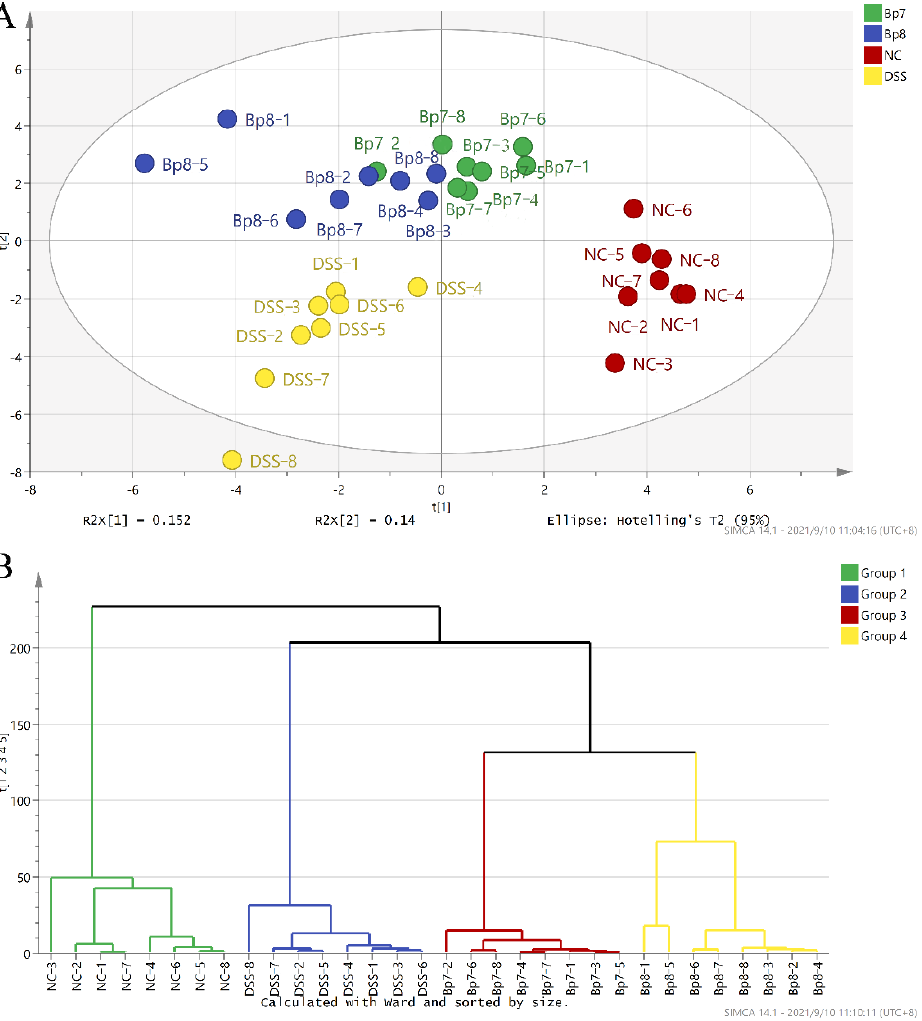
Figure 7. Influence of Bp7 and Bp8 intervention on the intestinal microbiota structure. PCA ( A ); HCA ( B ).